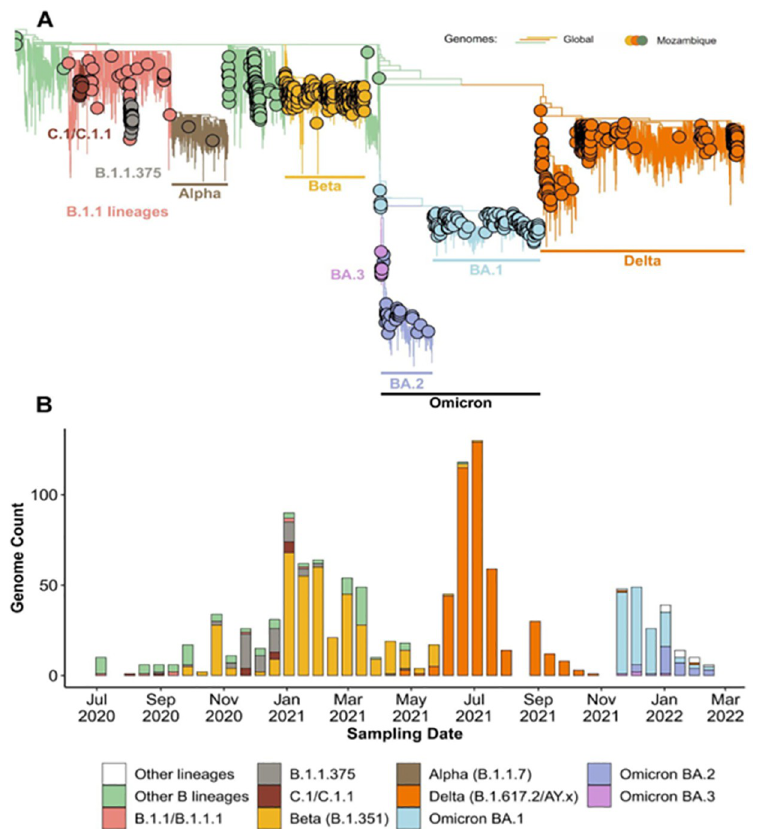
Fig 3. Lineage and phylogenetic analysis. (A) Phylogenetic tree of SARS-CoV-2 sequences representing global and Mozambique subsets during the first 25 months of the pandemic. Taxa obtained from Mozambique are illustrated with circles and the lines represent taxa from the global dataset. (B) Lineage through time plots illustrate the change in genetic diversity of sequenced genomes sampled in Mozambique throughout the study period.